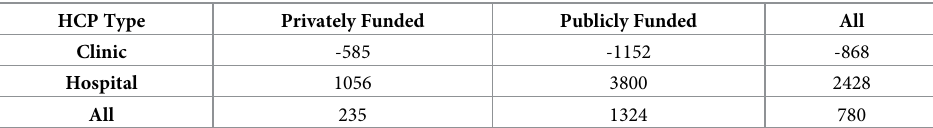
Table 2. Mean attractiveness index for all HCPs across all slums.